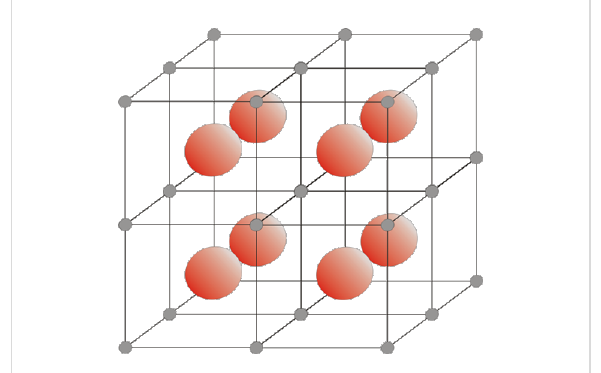
Figure 2: Idealized 3D cave structure of a NP cluster. Grey spheres: MNP, lines: [Fe(II)(bzimpy) 2 ] linking units, orange spheres: possible intercalated molecules.